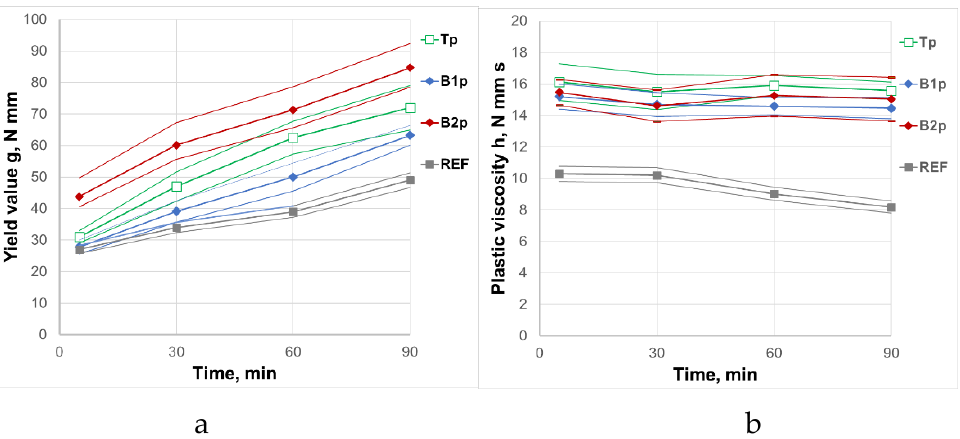
Figure 2. Influence of processed CFA on rheological properties of mortars and its variability. ( a ) Yield value g; ( b ) Plastic viscosityh.